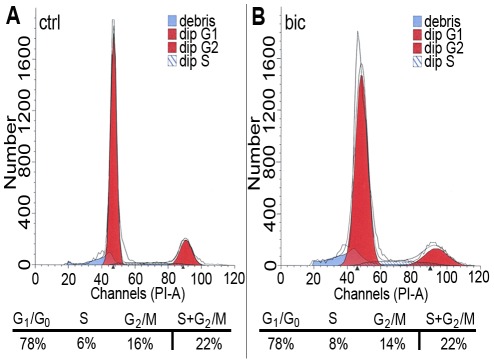
Distribution of NPE cells in the cell cycle phases after treatment with bicuculline.Flow cytometry analysis of PI labelled NPE cells. Graphs are showing PI fluorescence intensity (DNA content) per event. (A) Control cells (1 µM GABA) and (B) bicuculline-treated cells (20 µM bicuculline, 1 µM GABA). Red peaks from left: G1-, and G2-phase. Tables list the percentage of cells present in the cell cycle phases calculated by the ModFit LT DNA analysis software.